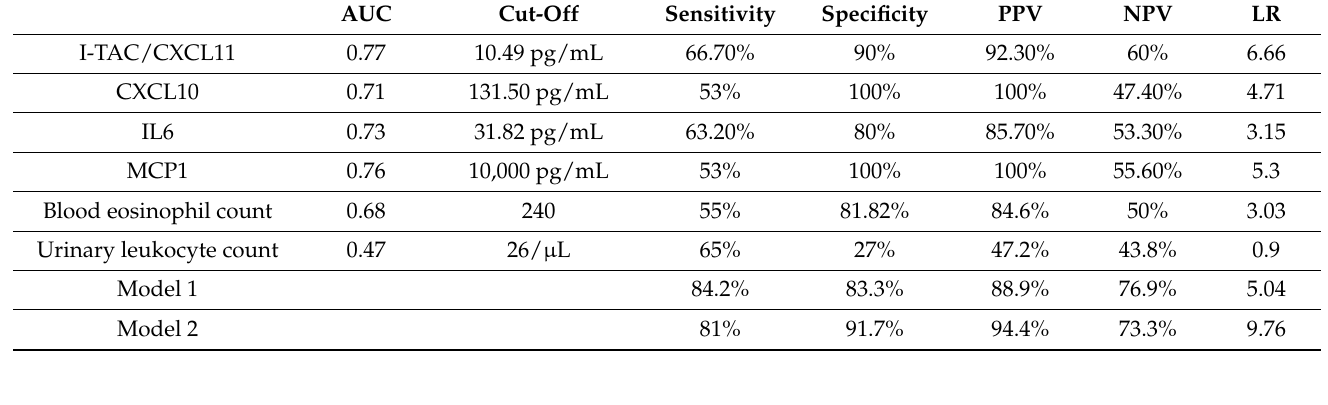
Table 6. Biomarker characteristics. PPV—positive predictive value. NPV—negative predictive value. LR—likelihood ratio.